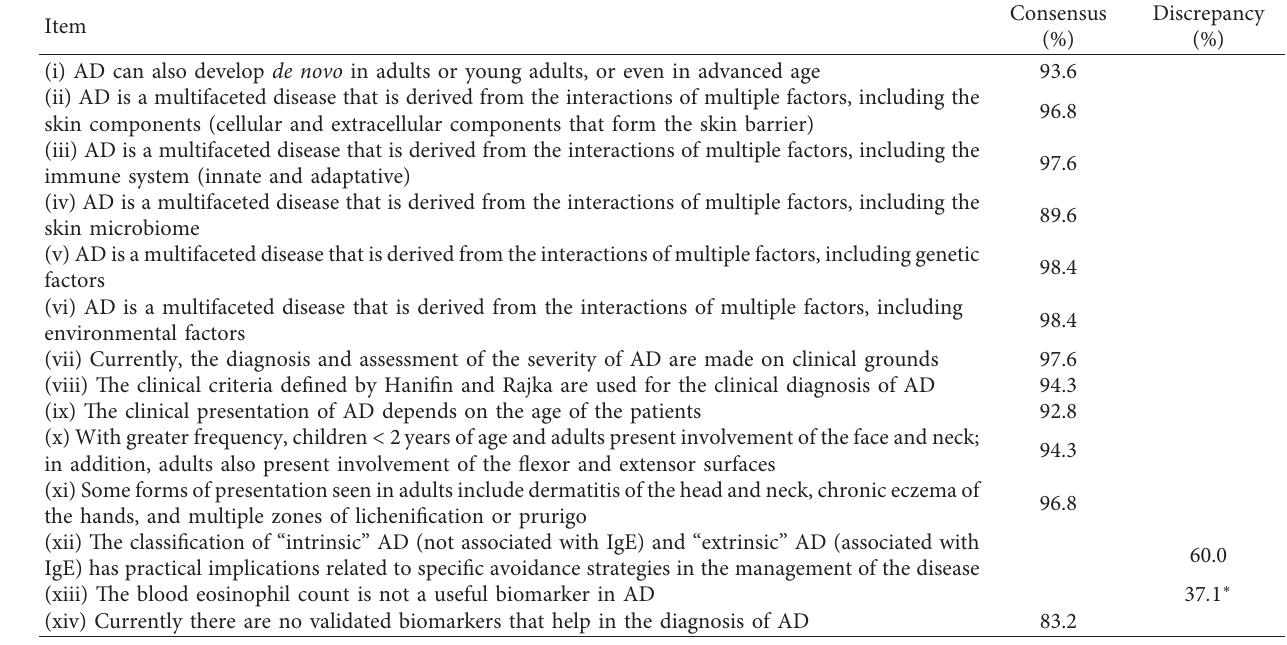
Table 2: Results regarding definition and diagnosis of